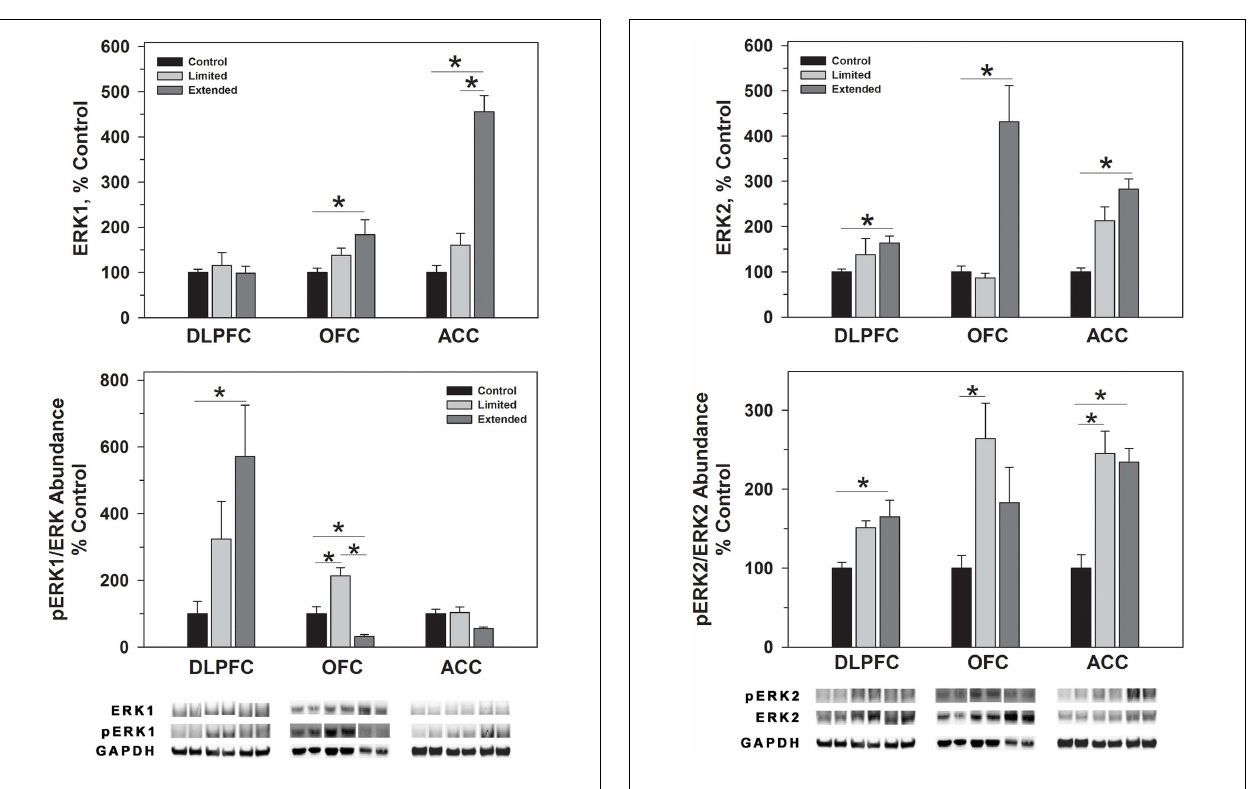
FIGURE 3 | Protein levels of ERK1 and pERK1 in prefrontal regions following limited and extended access to cocaine self-administration . Cytosolic fractions were isolated as described in the Section “Materials and Methods” and 10 µ g were separated on 10% SDS-PAGE. Data are expressed as mean ( ± SEM) of the percent of control values per amount of protein loaded. Asterisks indicate a significant difference ( P < 0.05). Bottom Panel: Representative bands from two subjects per group per region.